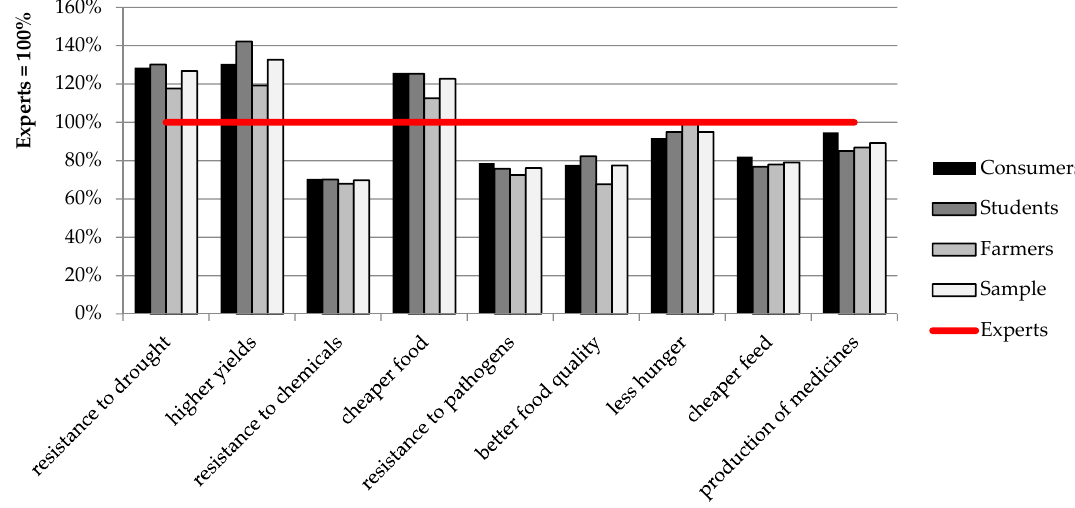
Figure 2. Comparison of respondent and expert assessments of the potential effects of introducing GMO technologies in crops. Source: Own research. Table 3. To what extent do you agree with the following statements regarding GM foods?